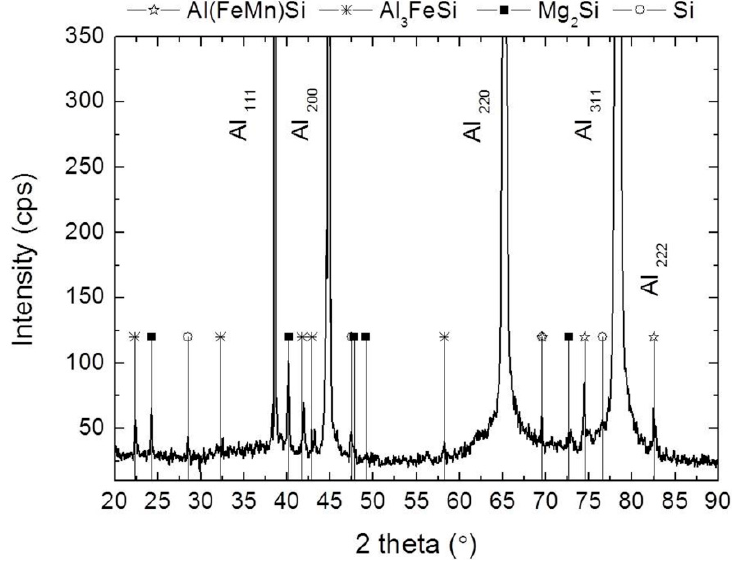
Figure 4. X-Ray diffraction (XRD) pattern of the profiles extruded at 500 ° C from AA 6005A compacted powders. compacted